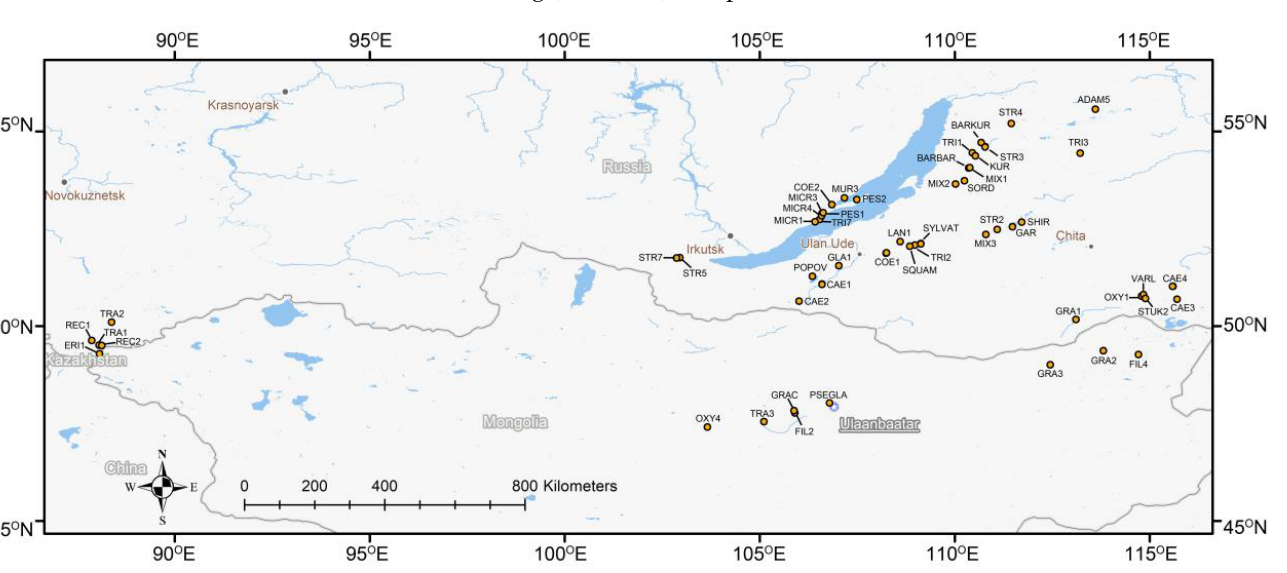
Figure 1. Map of sample sites for natural populations of Oxytropis species from Southern Siberia (69 population, light brown circles). Population codes as in Table 1.